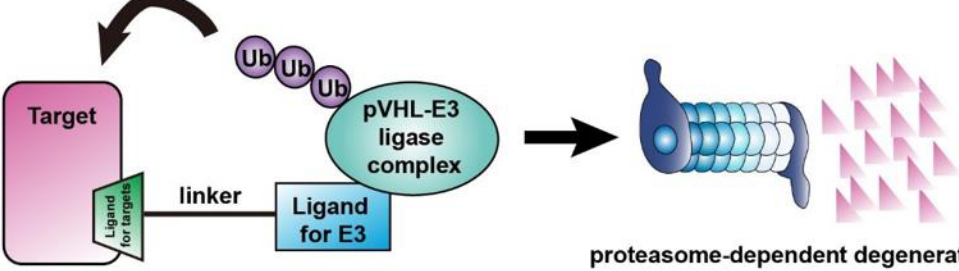
Figure 3. A schematic diagram for pVHL-based PROteolysis-TArgeting Chimeras (PROTACs).